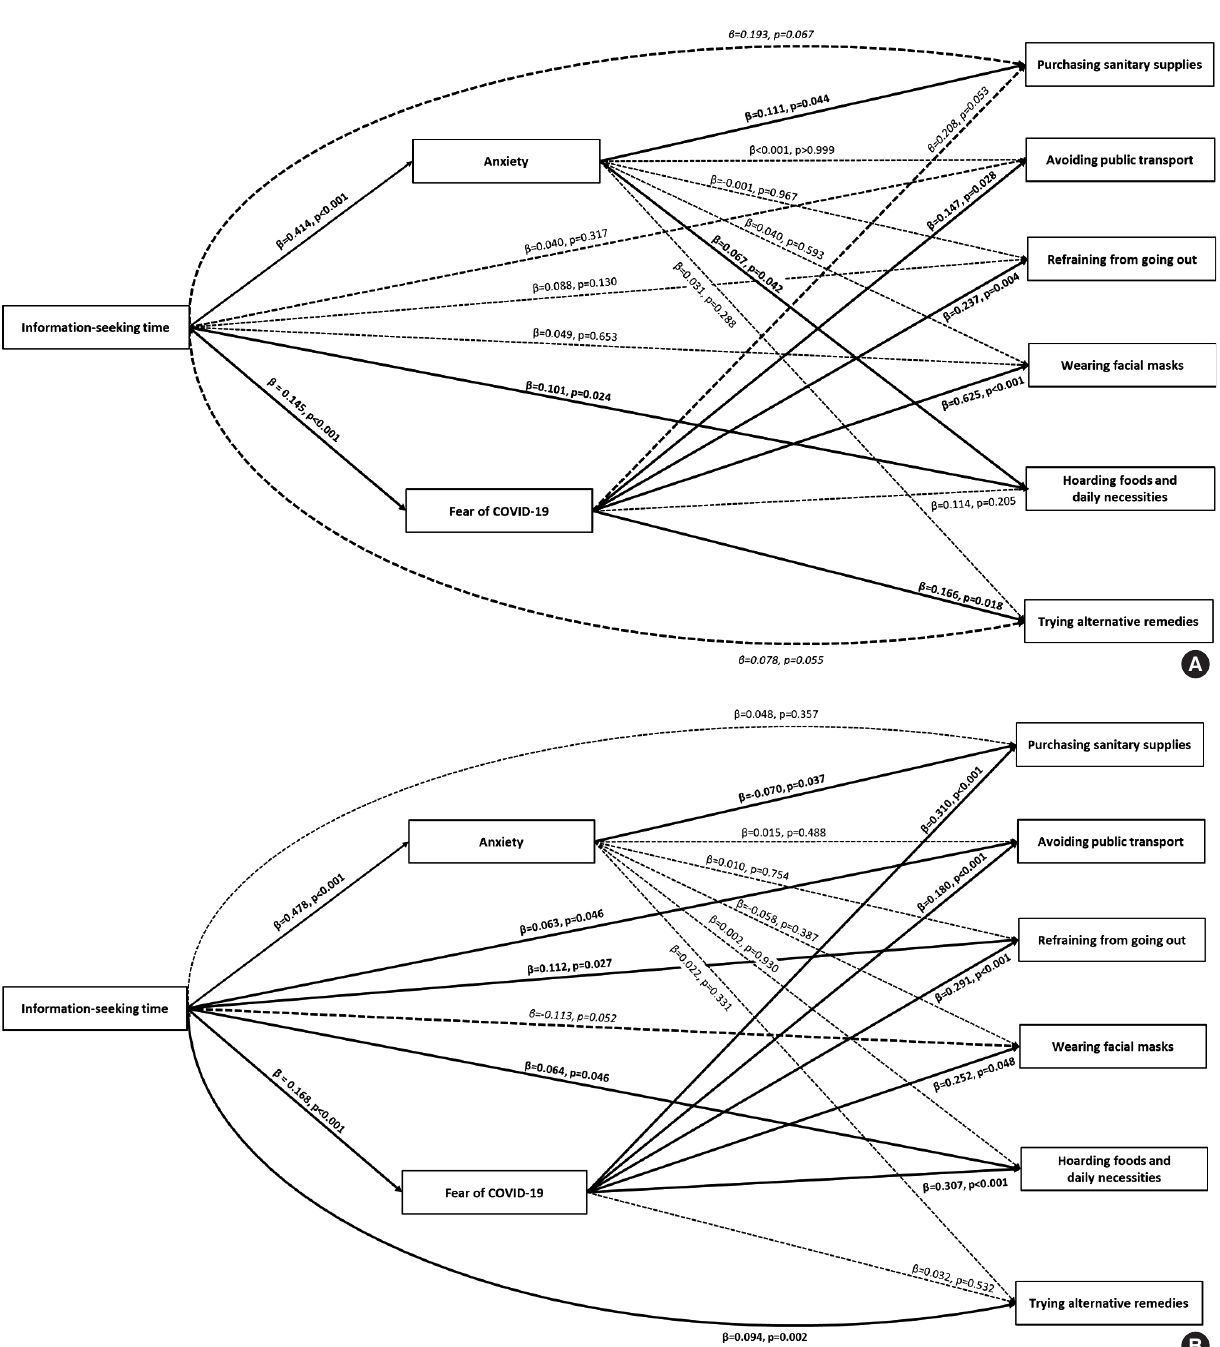
Figure 3. Conceptual diagram of the associations among information-seeking time, anxiety and fear of coronavirus disease 2019 (COV- ID-19), and prevention behaviours in men (A) and women